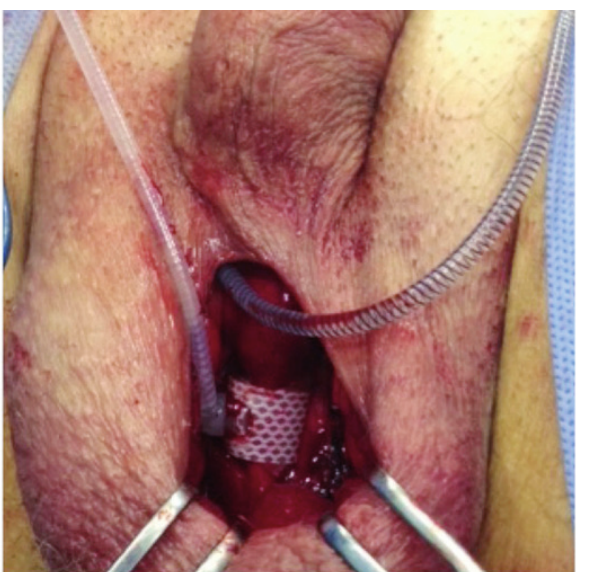
Figure 2 - Bulbar urethra placement of As in modified scrotal approach.